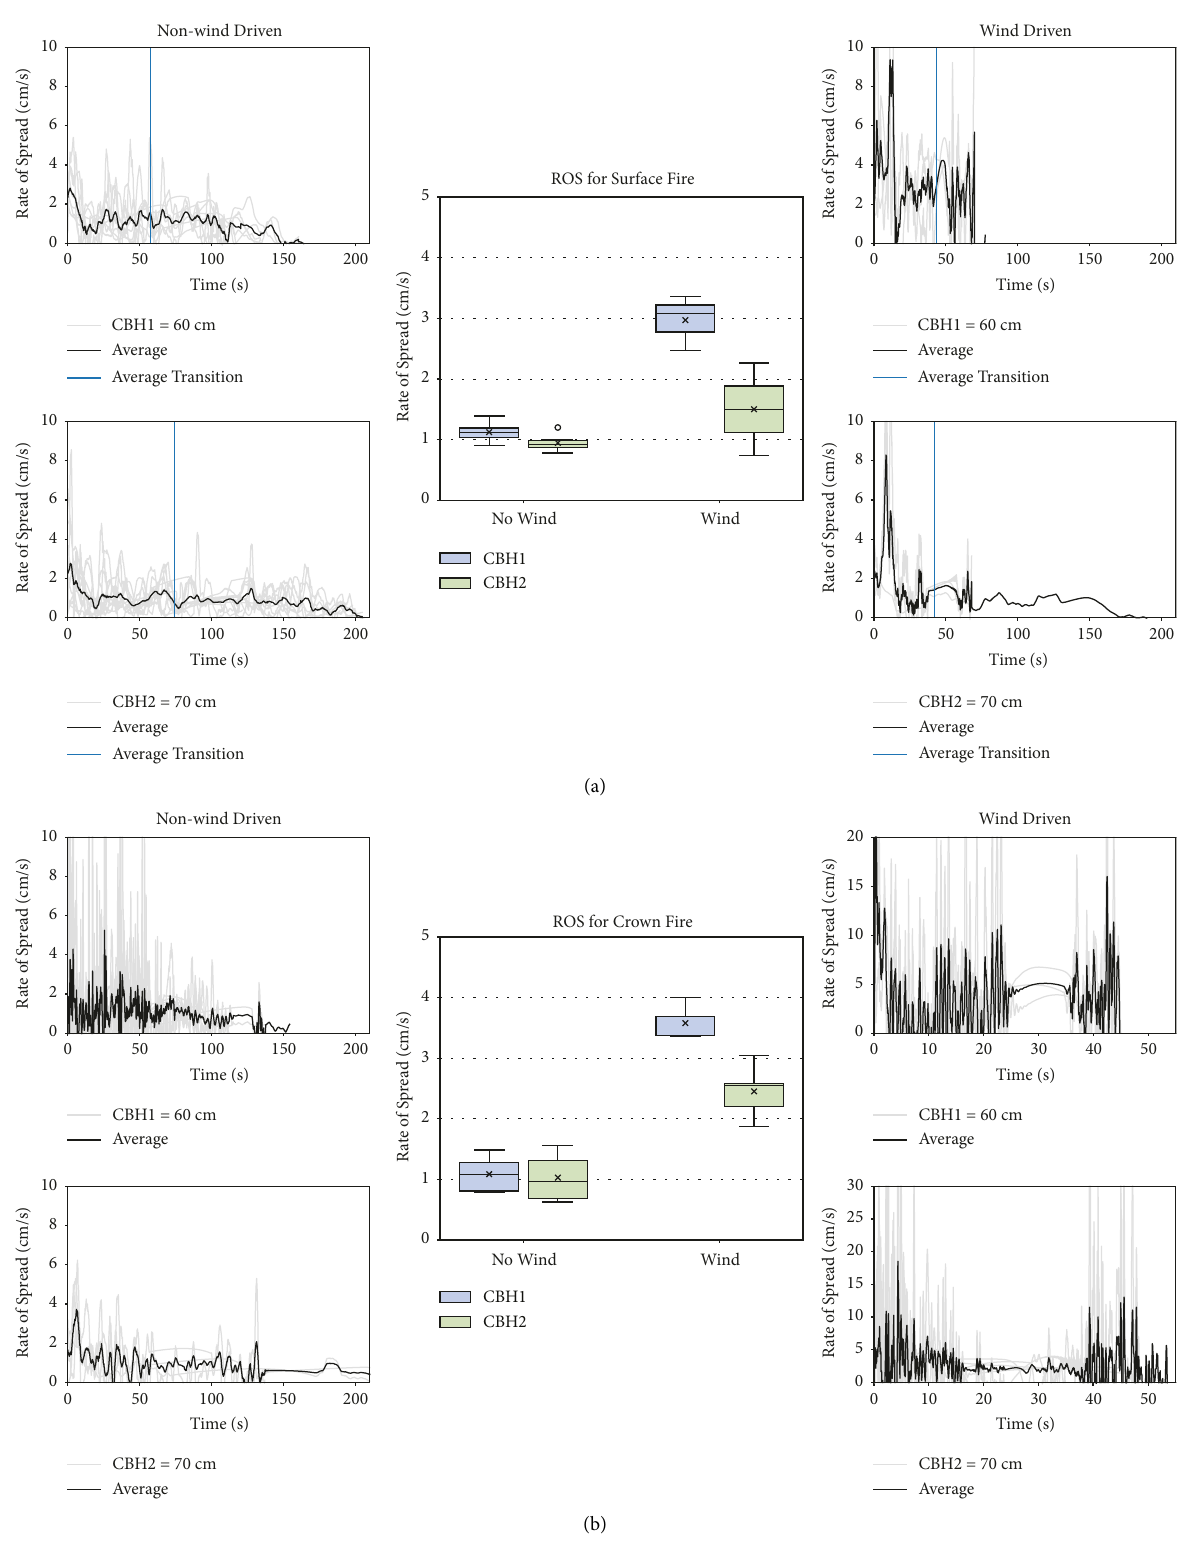
Figure 6: Rate of spread behavior in (a) surface fires and (b) crown fires. Rate of spread in nonwind-driven fires (left columns), wind-driven fires (right columns), and a box and whisker plot for the average rate of spread for all experiments (middle). On the box and whisker plot, the black line represents the median and the black “ x ” represents the